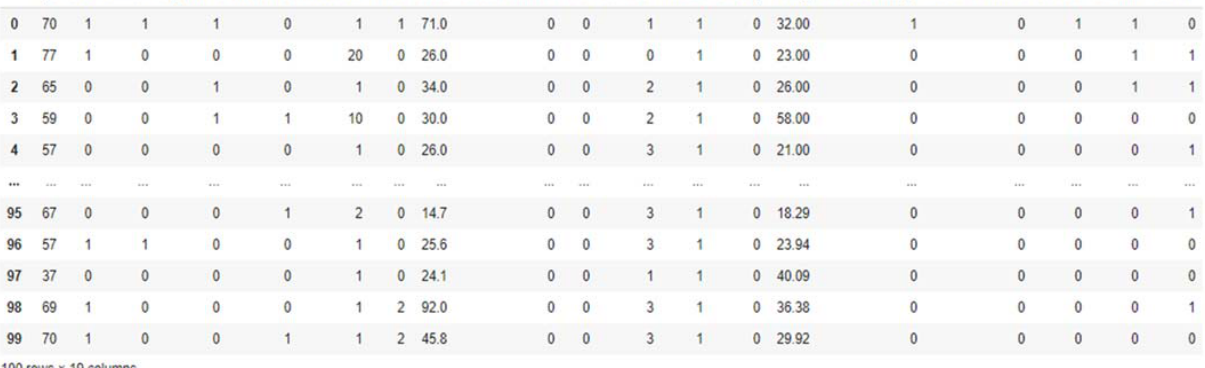
Figure 2. Exemplification of input data (the columns entitled ‘semo011’ and ‘sem012’ correspond to halo sign—referring to part solid ground-glass opacity—and feeding blood vessel sign, respec- tively).